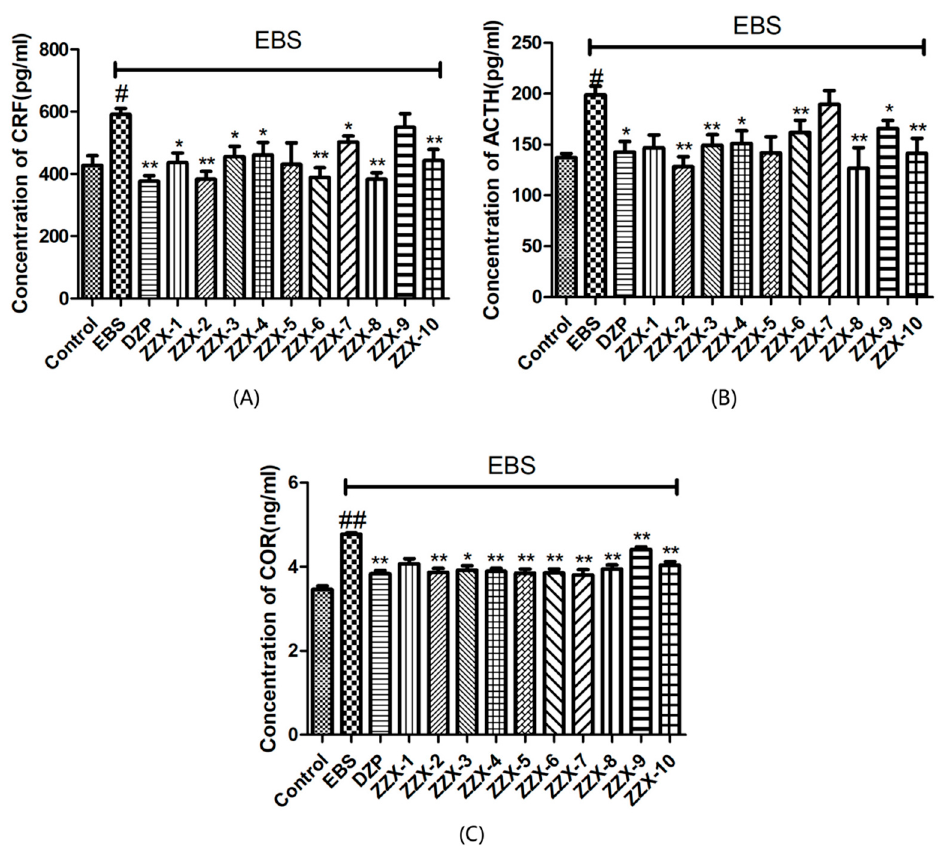
Figure 5. Effect of ZZX on serum CRF, ACTH and CORT levels after the behavior tests. ( A ) Concentration of CRF (pg/mL); ( B ) concentration of ACTH (pg/mL); ( C ) concentration of COR (ng/mL). Bars represent mean ± SEM. # represent p < 0.05 compared to the control group; ## represent p < 0.01 compared to the control group; * represent p < 0.05 compared to the EBS/ZZX group; ** represent p < 0.01 compared to the EBS/ZZX group. One-way ANOVA with Student-Newman-Keuls post hoc test.